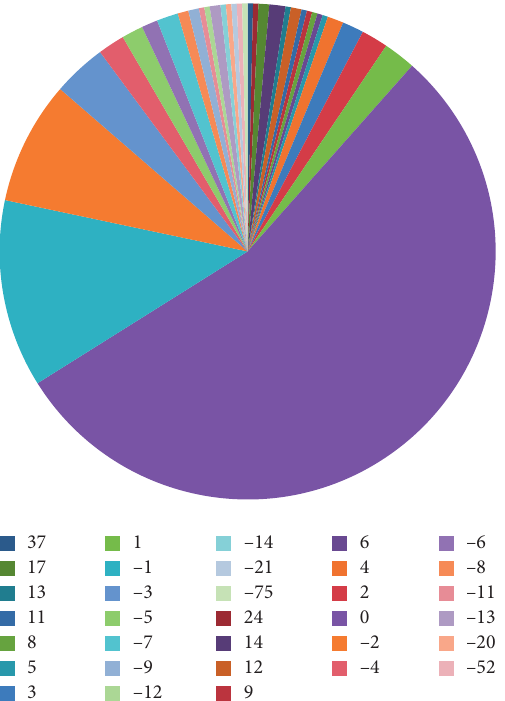
Figure 4: The distribution of net talent flows of doctoral